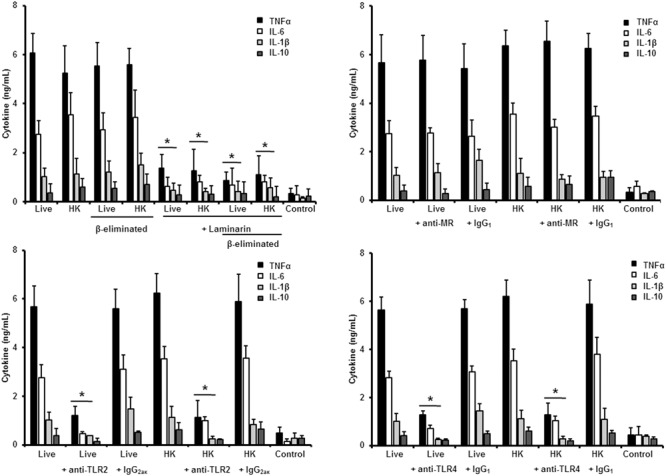
Cytokine production by human PBMCs stimulated with S. schenckii sensu stricto germlings. As Figure 3, but germlings were used. ∗P < 0.05, when compared with untreated cells.